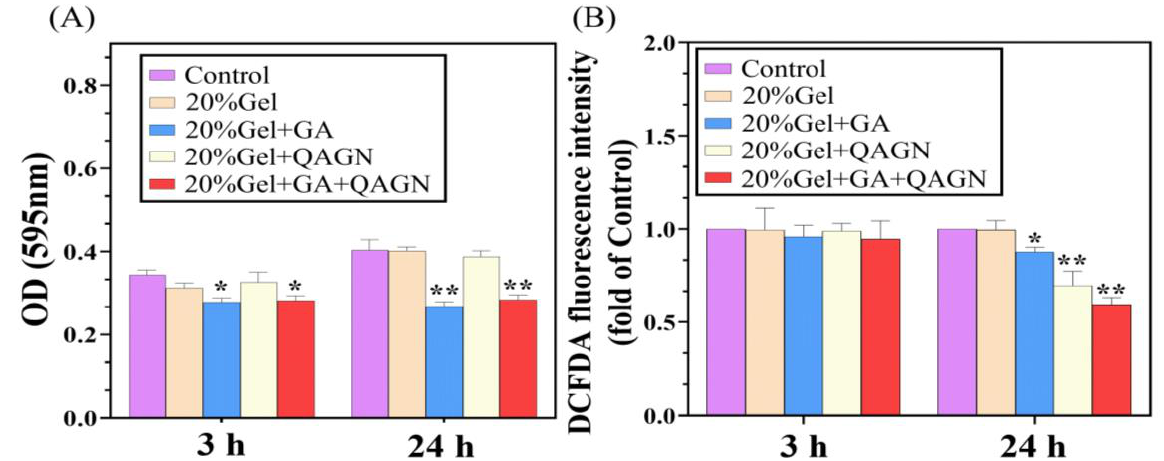
Figure 7. MN patches for in vitro biological activity analysis. ( A ) Cell proliferation assessment: chondrocytes were co-cultured with various loaded MN patches for 3 and 24 h (data are presented as mean ± SD, * p < 0.05, ** p < 0.01); ( B ) ROS relative content analysis (mean ± SD, n = 5).